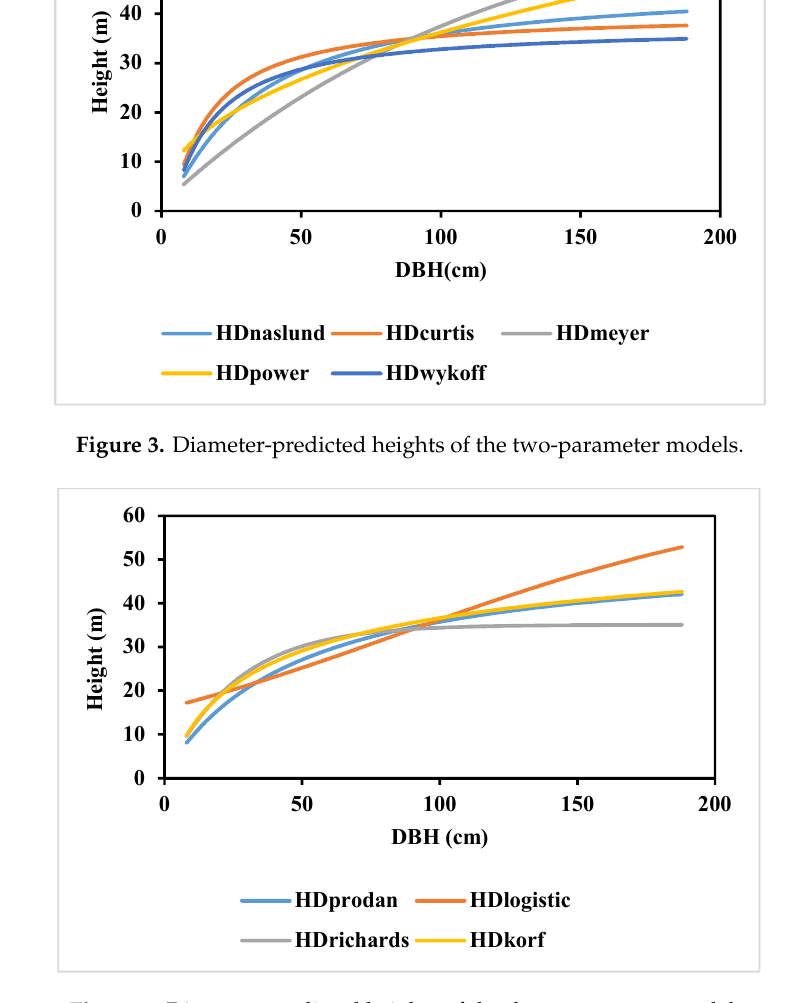
Figure 4. Diameter-predicted heights of the three-parameter models.